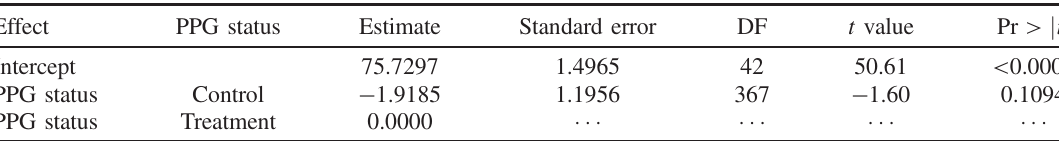
TABLE VI. Model results for annual chemistry